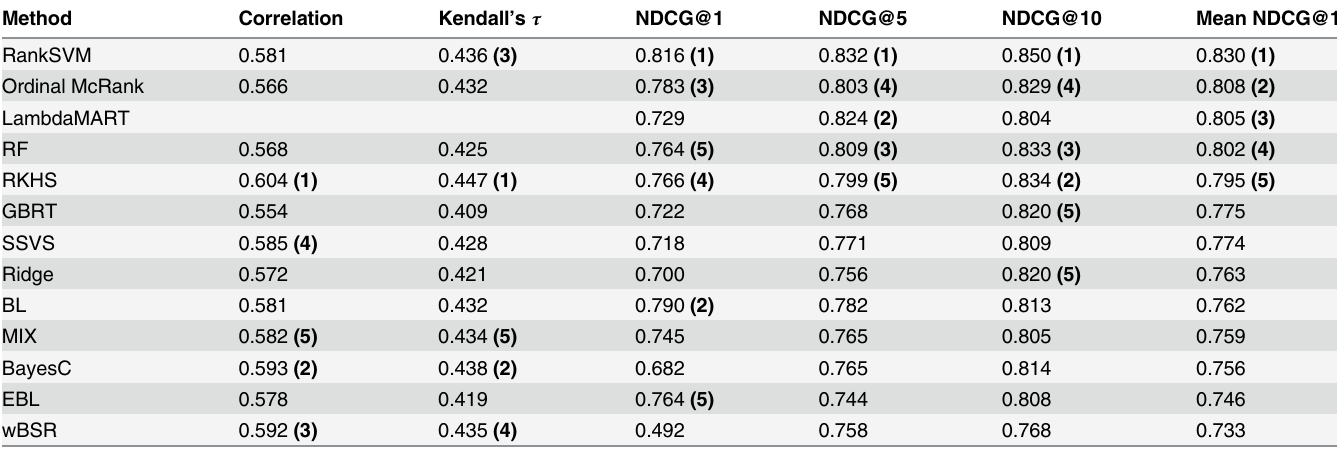
Table 3. Cross-validation results on the Barley